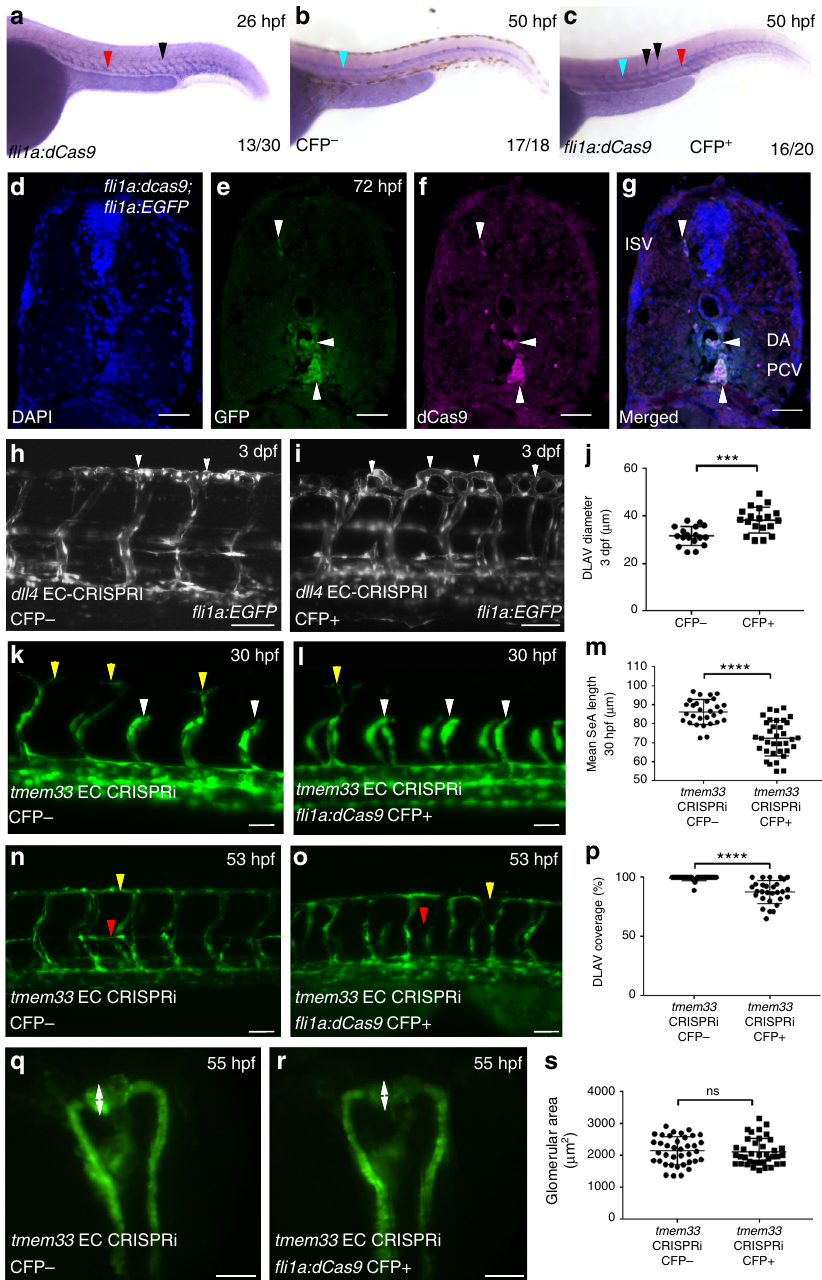
Fig. 3 Injection of sgRNAs targeting tmem33 into stable Tg( fl i1a:dCas9;cryaa:CFP) sh512 embryos recapitulates knockdown of tmem33 . a dCas9 is expressed within the developing vasculature (red arrowhead) including SeAs (black arrowheads) in ~50% of progeny from a Tg( fl i1a:dCas9;cryaa:Cerulean) sh512 / + outcross at 26 hpf. At this stage the dominant cryaa:Cerulean marker is not expressed. b dCas9 is not expressed within the developing vasculature in CFP - Tg ( fl i1a:dCas9;cryaa:Cerulean) sh512 transgenic embryos at 50 hpf. Probe trapping in notochord is highlighted (blue arrowhead). c dCas9 is expressed within the dorsal aorta (red arrowhead) and SeAs (black arrowheads) in CFP + Tg( fl i1a:dCas9;cryaa:Cerulean) sh512 transgenic embryos at 50 hpf. Probe trapping in notochord is highlighted (blue arrowhead). d – g Colocalisation of dCas9 and GFP in 72 hpf fl i1a:dCas9 ; fl i1a:EGFP embryo indicates EC restricted expression of dCas9 (white arrowheads) Scale bars 20 μ m. h , i Tg( fl i1a:dCas9;cryaa:Cerulean) embryos injected with sgRNA targeting dll4 phenocopies ectopic vascular looping within the DLAV previously observed in dll4 morphants and mutants at 3 dpf (white arrowheads). j Tg( fl i1a:dCas9;cryaa:Cerulean) -positive embryos injected with sgRNAs targeting dll4 display increased DLAV diameter (unpaired t -test *** p = < 0.001; t = 4.203 DF = 35; 2 repeats; n = 9 embryos per group). Scale bars 50 µ m. k-m Tg( fl i1a:dCas9;cryaa:Cerulean) embryos injected with sgRNAs targeting tmem33 display reduced SeA length (yellow arrowheads highlight normal SeAs, white arrowheads highlight delayed SeAs) at 30 hpf (unpaired t -test *** p = < 0.0001; t = 6.716 DF = 62; 3 repeats; n = 9 – 12 embryos per group). Scale bars 50 µ m. n – p Tg( fl i1a:dCas9;cryaa:Cerulean) embryos injected with sgRNAs targeting tmem33 display absent parachordal lymphangioblasts (red arrowhead) and reduced DLAV continuity (yellow arrowheads) (unpaired t -test *** p = < 0.0001; t = 6.399 DF = 56; 3 repeats; n = 9 – 11 embryos per group). Scale bars 50 µ m. q – s Tg( fl i1a:dCas9;cryaa:Cerulean) embryos injected with sgRNAs targeting tmem33 display no signi fi cant difference in glomerular area, compared with Tg( fl i1a:dCas9;cryaa:Cerulean) -negative siblings embryos (unpaired t -test, ns = not signi fi cant; t = 0.4048; DF = 74; 3 repeats; n = 12 – 13 embryos per group). Scale bars 200 µ m. Source data are provided as a Source Data fi